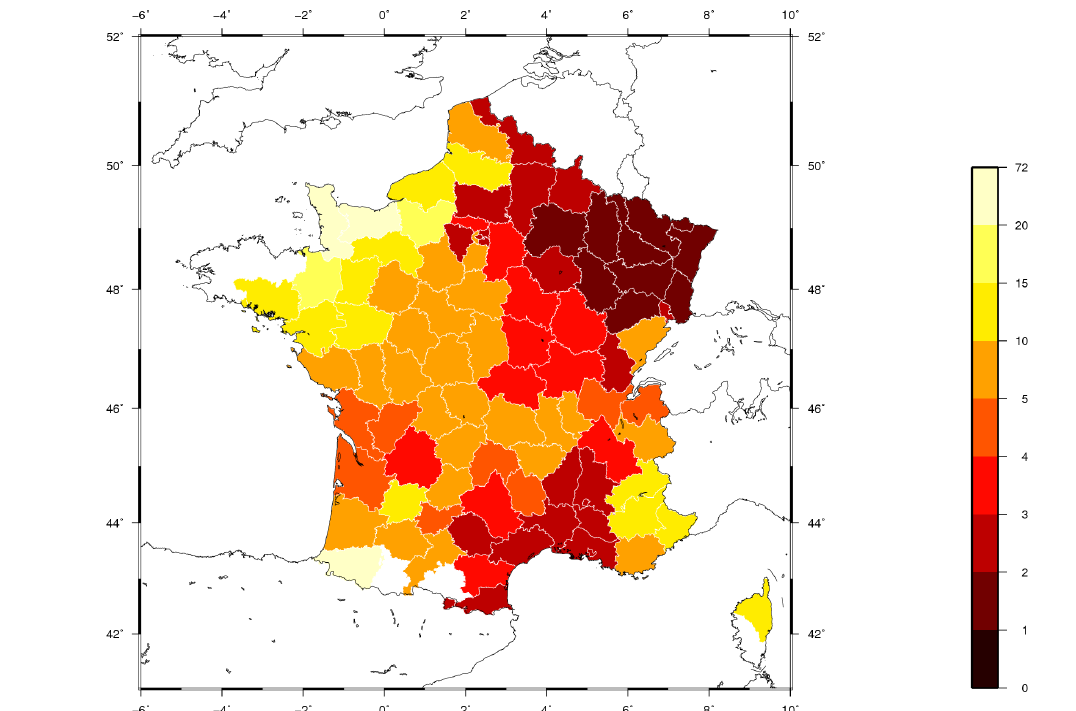
Figure 9. Rank per county in term of global intensity for the 2018 heat wave. White colour corresponds to a county with no wave